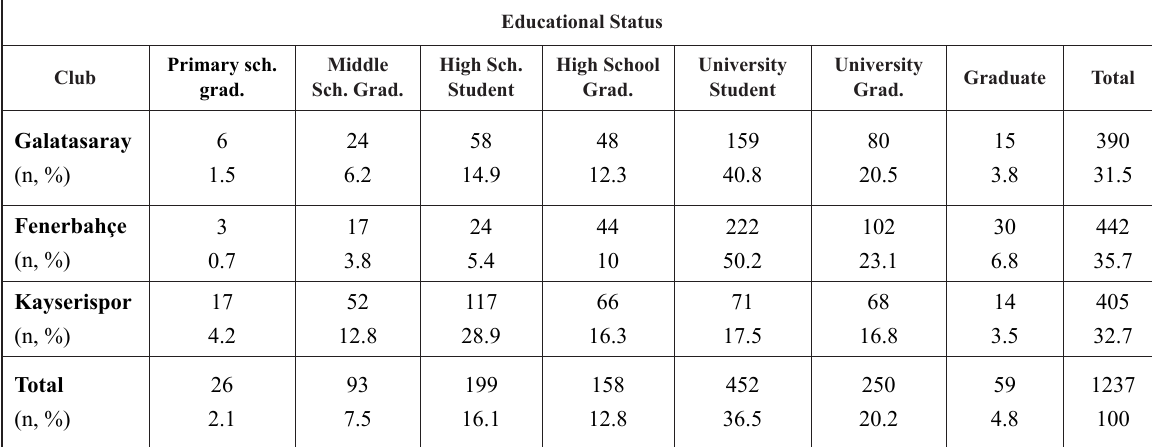
Table 3. Distribution according to education status of participants